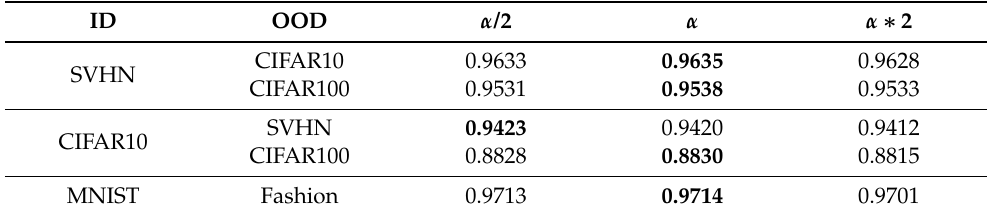
Table 8. Comparison of the OOD detection performance measure by AUROC with different settings of α . Bold numbers are superior results.